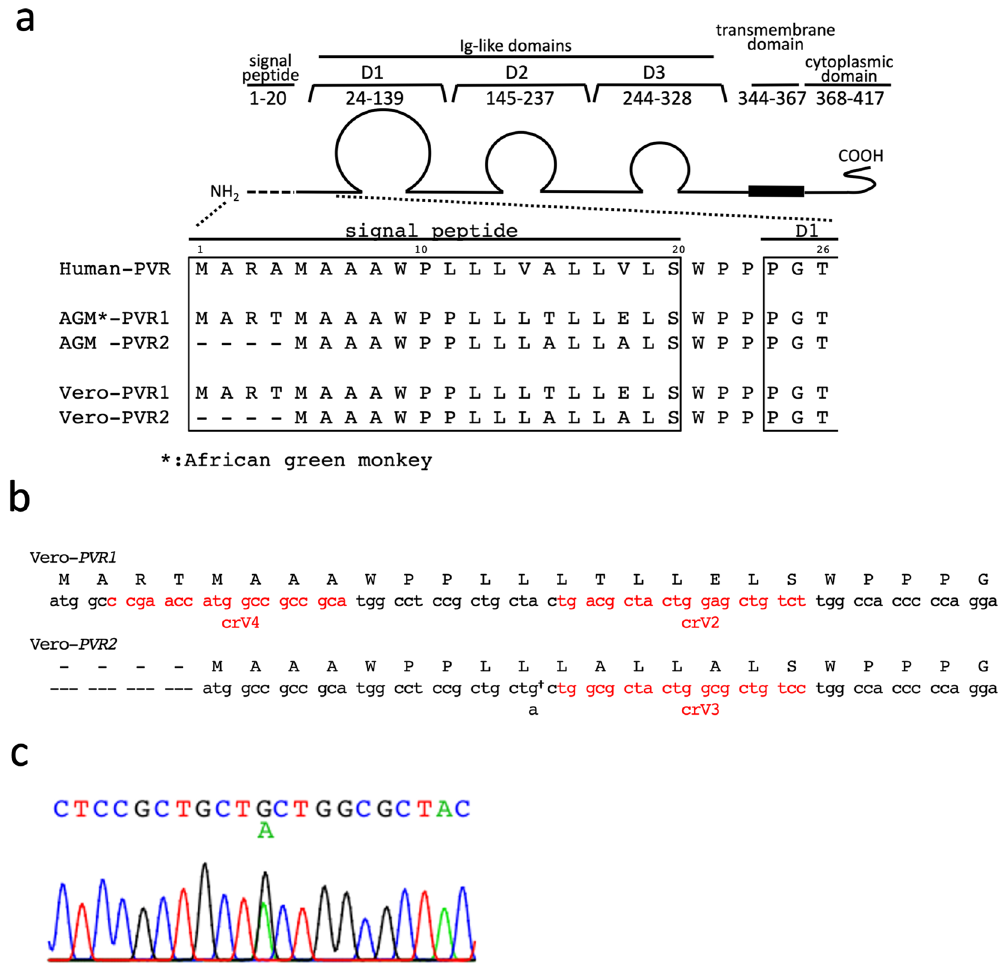
Figure 1. Generation of PVR1 / PVR2 DKO Vero cell lines. ( a ) Diagram of PVR. The signal peptide and the N-terminus of the first domain (D1) of the three Ig-like domains, which is responsible for viral recognition, is encoded by exon 1 of the human PVR gene. Amino acid sequences are aligned with AGM ( Chlorocebus sabaeus ) or Vero PVRs (see also Supplementary Table 1). ( b ) Nucleotide sequences of the initial ATG codon and downstream region in Vero- PVR1 and Vero- PVR2. Genomic DNA of Vero cells were extracted and the coding region located on exon 1 of PVR1 and PVR2 were sequenced. DNA sequences of Vero- PVR1 and Vero- PVR2 are shown in lowercase letters; the predicted amino acid sequences are shown in capital letters. Vero- PVR2 was found to have a single-nucleotide variation (SNV) (†) in the open reading frame (ORF), probably due